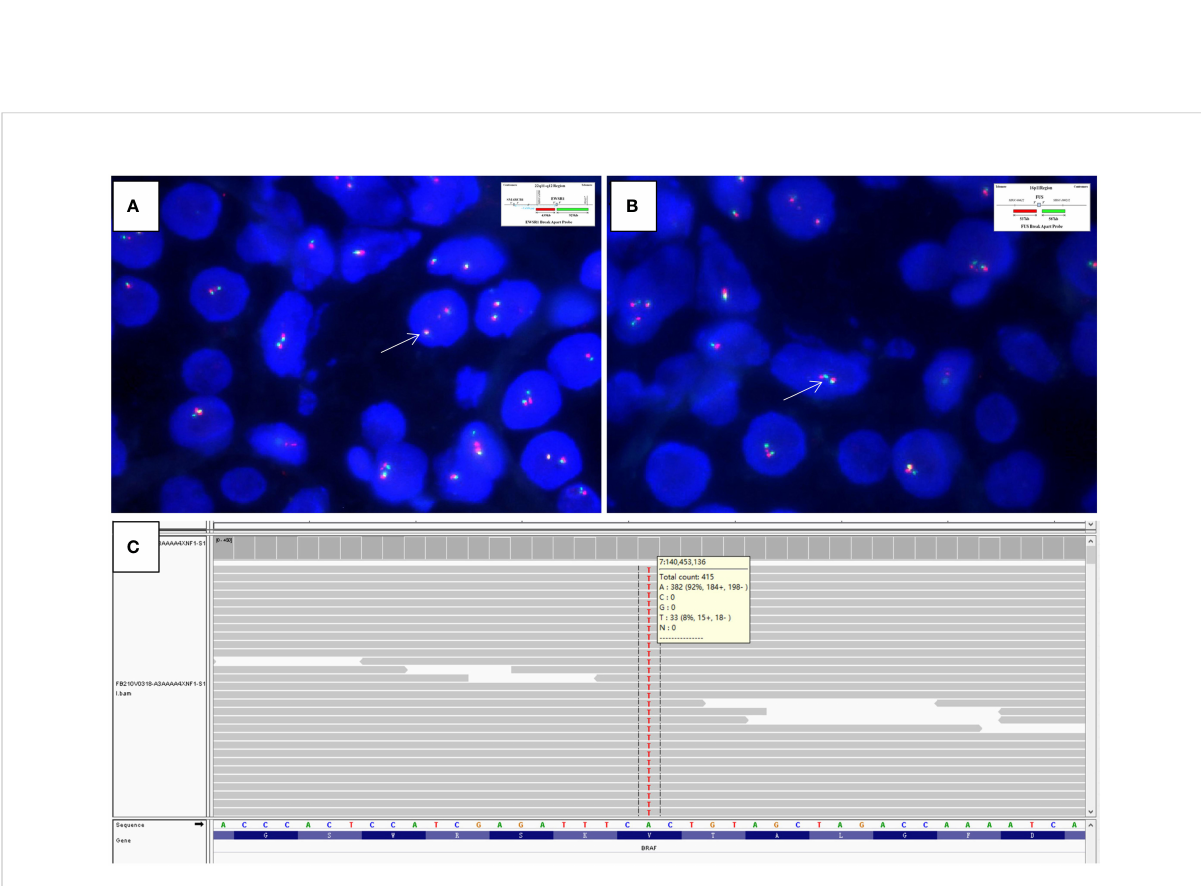
FIGURE 4 Fluorescence in-situ hybridization analysis is negative for rearrangements of both the (A) EWSR1 (×1500, arrows indicate fused green and orange signals) and (B) FUS (×2000, arrows indicate fused green and orange signals) loci (Insets in A and B indicate schematic diagram of break- apart probes fl anking EWSR1 and FUS , respectively). (C) Targeted next-generation sequencing discloses the pathogenic mutation of BRAF exon15: c.1799T>A (p.V600E) in the tumor, as illustrated by the Integrative Genomics Viewer